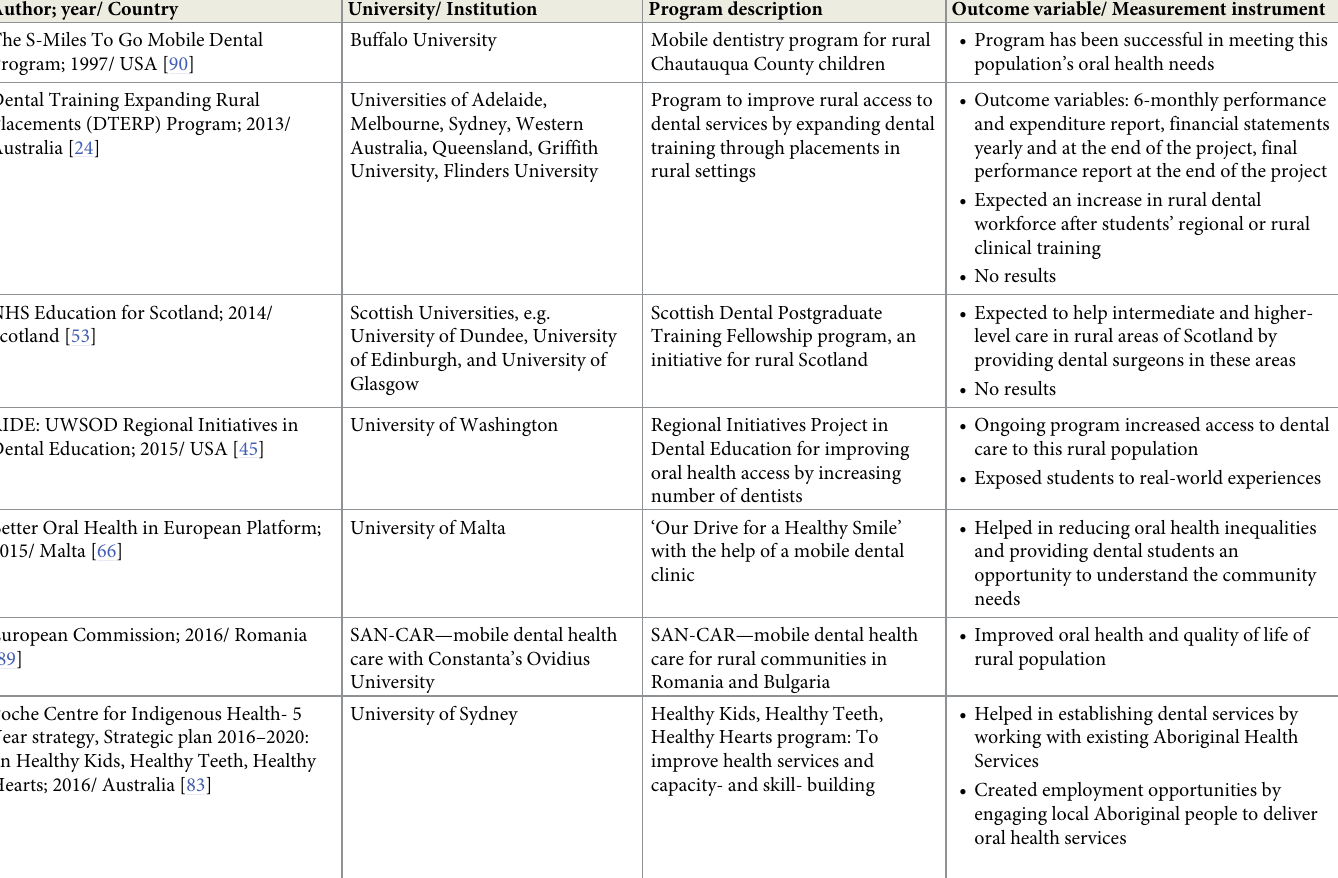
Table 6. Summary of non-research publications including relevant web records identified in the scoping